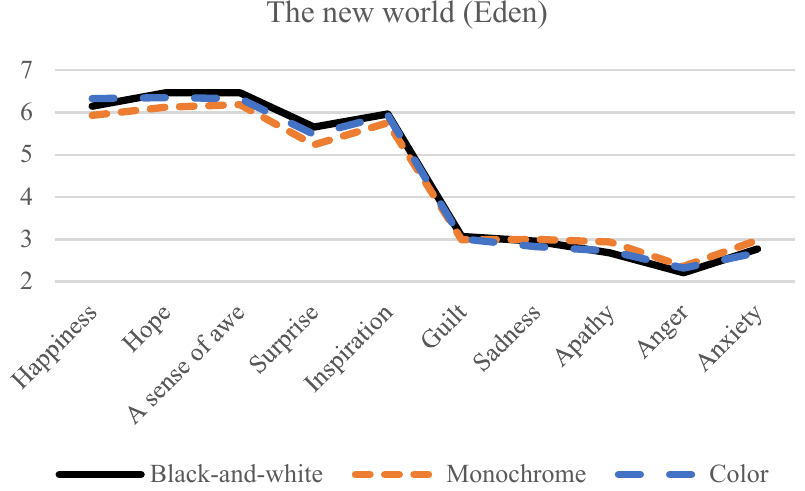
Figure 10. The line graph shows the average emotions of different colors in #5 image.